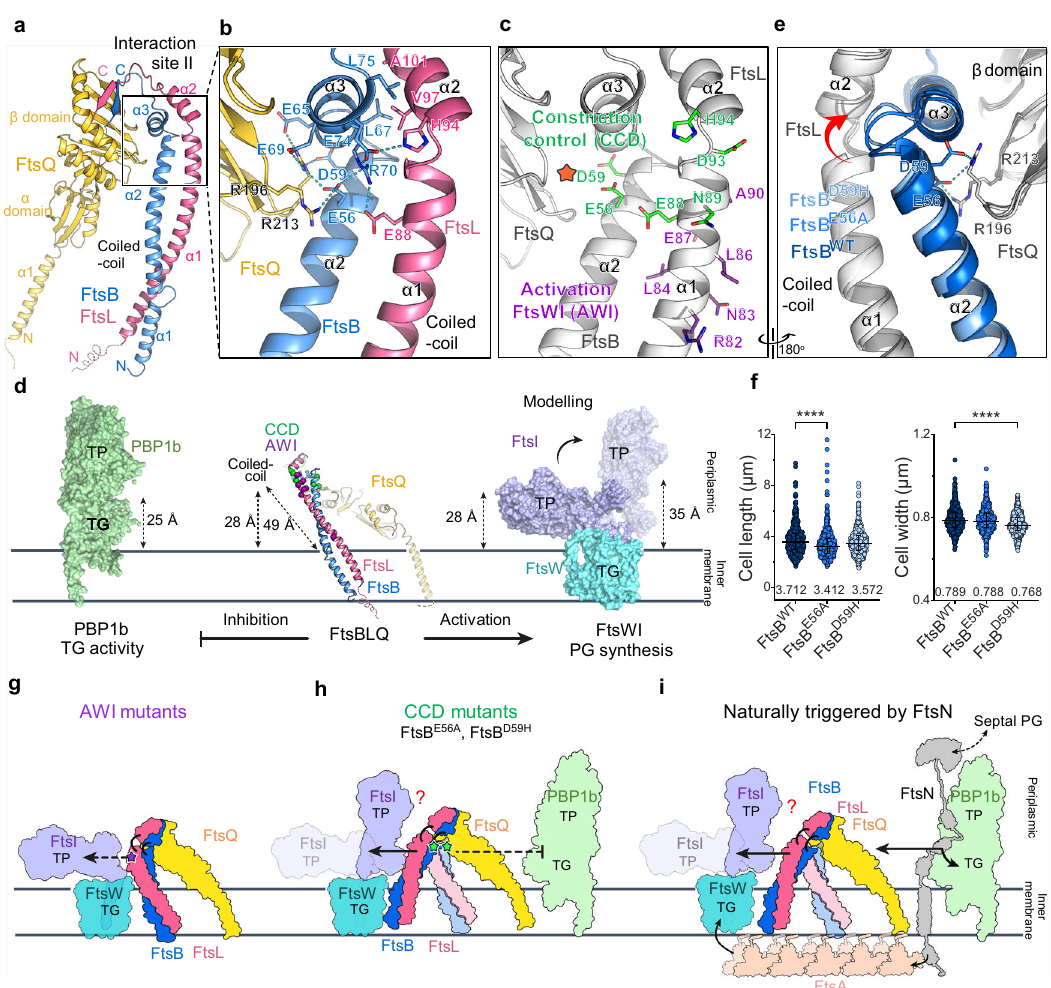
Fig.4|KeyfunctionalresiduesintheinteractionsiteIIandahypotheticmodel for the regulation of PG synthases. a Overall structure of the FtsBLQ complex highlighting the interaction site II in a box. b An enlarged view of the box in ( a ), labeling two short helices of FtsB ( α 2) and FtsL ( α 3) and the coiled coil, with interactingresiduesshowninsticksandhydrogenbondsinbluedashedlines. c Key residues of the Constriction Control Domain (CCD, green) and the Activation of FtsW-FtsI Domain (AWI, purple) overlap with the interaction site II. FtsB-FtsQ interface: orange star. d Distances measured from the membrane plane to the position of CCD and AWI residues of the FtsBLQ complex (middle, ribbon), to the upper side of the TG domain of PBP1b (5HLB, left, surface), and to the interacting residuesinFtsW-FtsI(modeledbasedon6PL5,right,surface).FtsB:blue;FtsL:pink; FtsQ: yellow; PBP1b: green; FtsW: cyan; FtsI: purple; CCD: green, C α spheres; and AWI: purple, C α spheres. The largest possible distanceof the key residues in FtsWI was measured by fl ipping the periplasmic domain of FstI for 90° upwards. The regulatory relationship between them is shown below the molecules. e Crystal